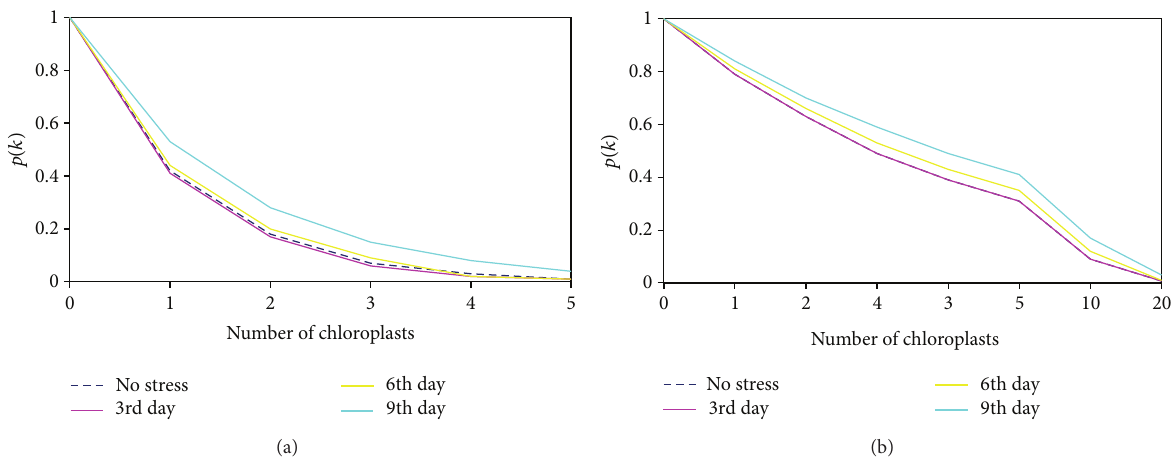
0.00.20.40.60.8